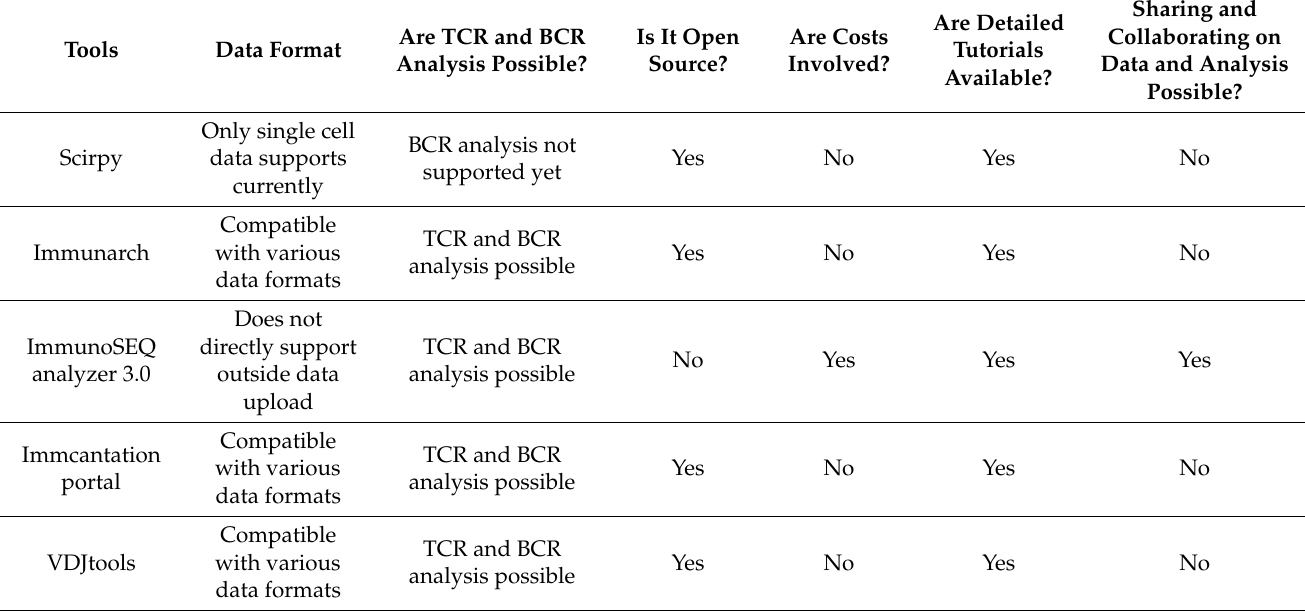
Table 1. Overview of commonly used tools in